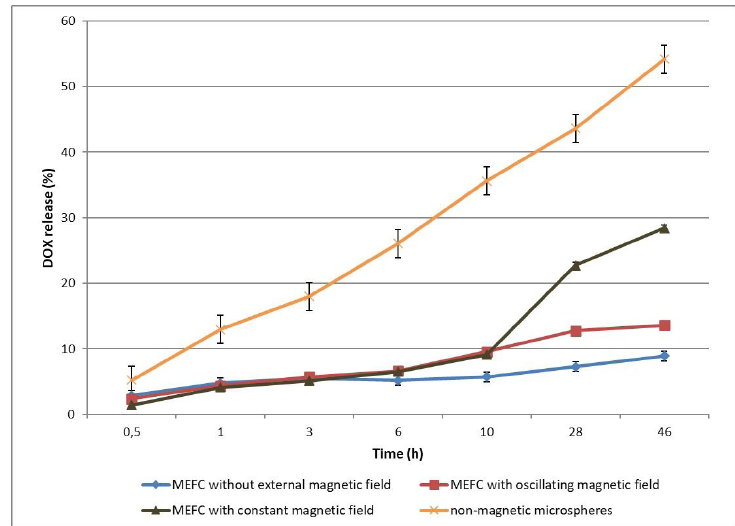
Figure 8. Microspheres based on gelatin, fructose magnetite obtained by ferrous chloride (sample MEFC) Doxorubicin